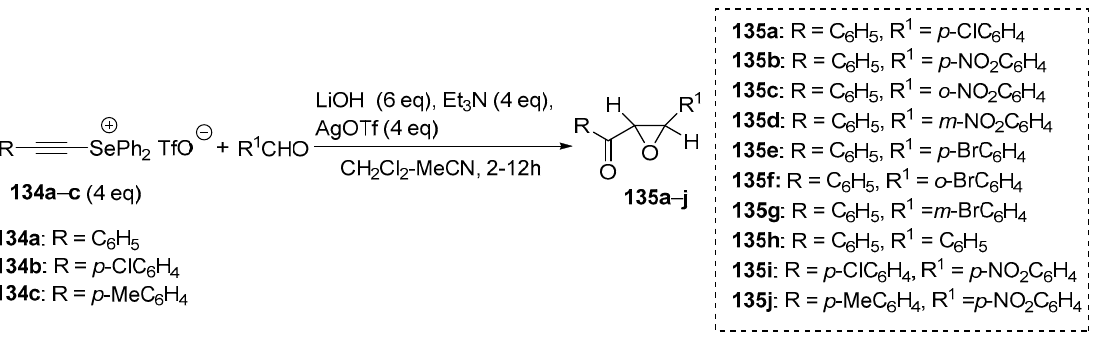
Table 9. Reaction time and yields of oxiranylketones 135a – j obtained in the reaction of ketoselenonium ylides 134a – c with aromatic aldehydes.